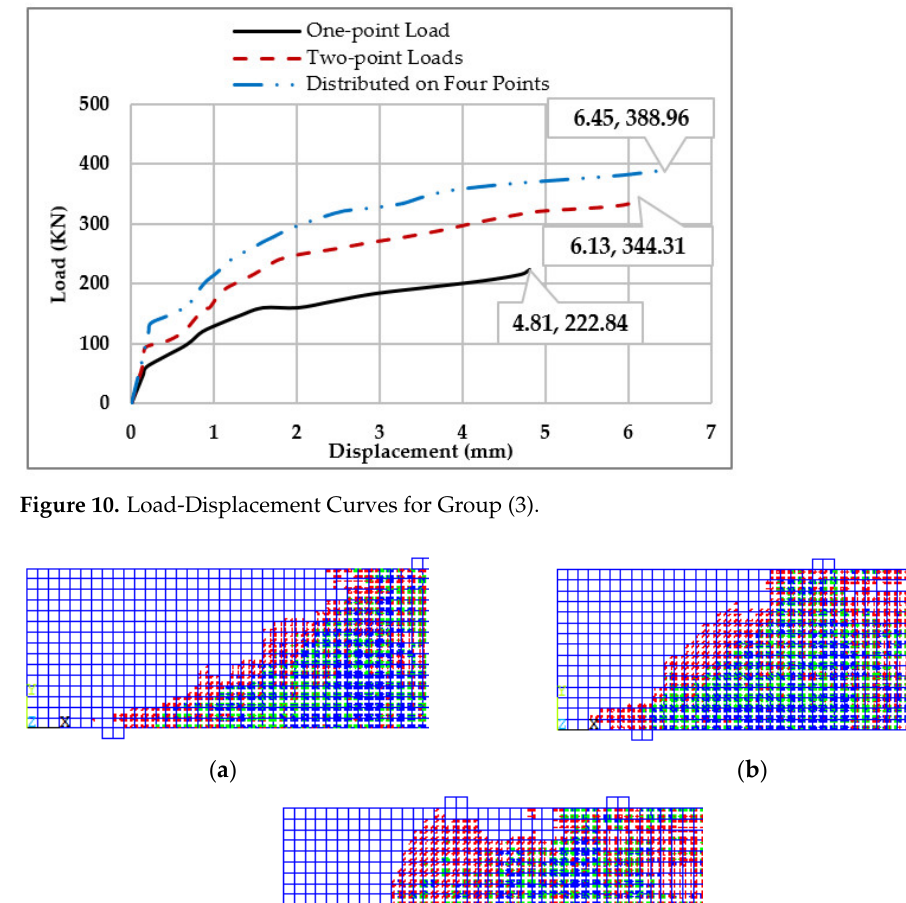
Figure 11. Crack Patterns for Group (3). ( a ) One-Pont Load. ( b ) Two-Point Loads ( c ) Distributed Load on Four